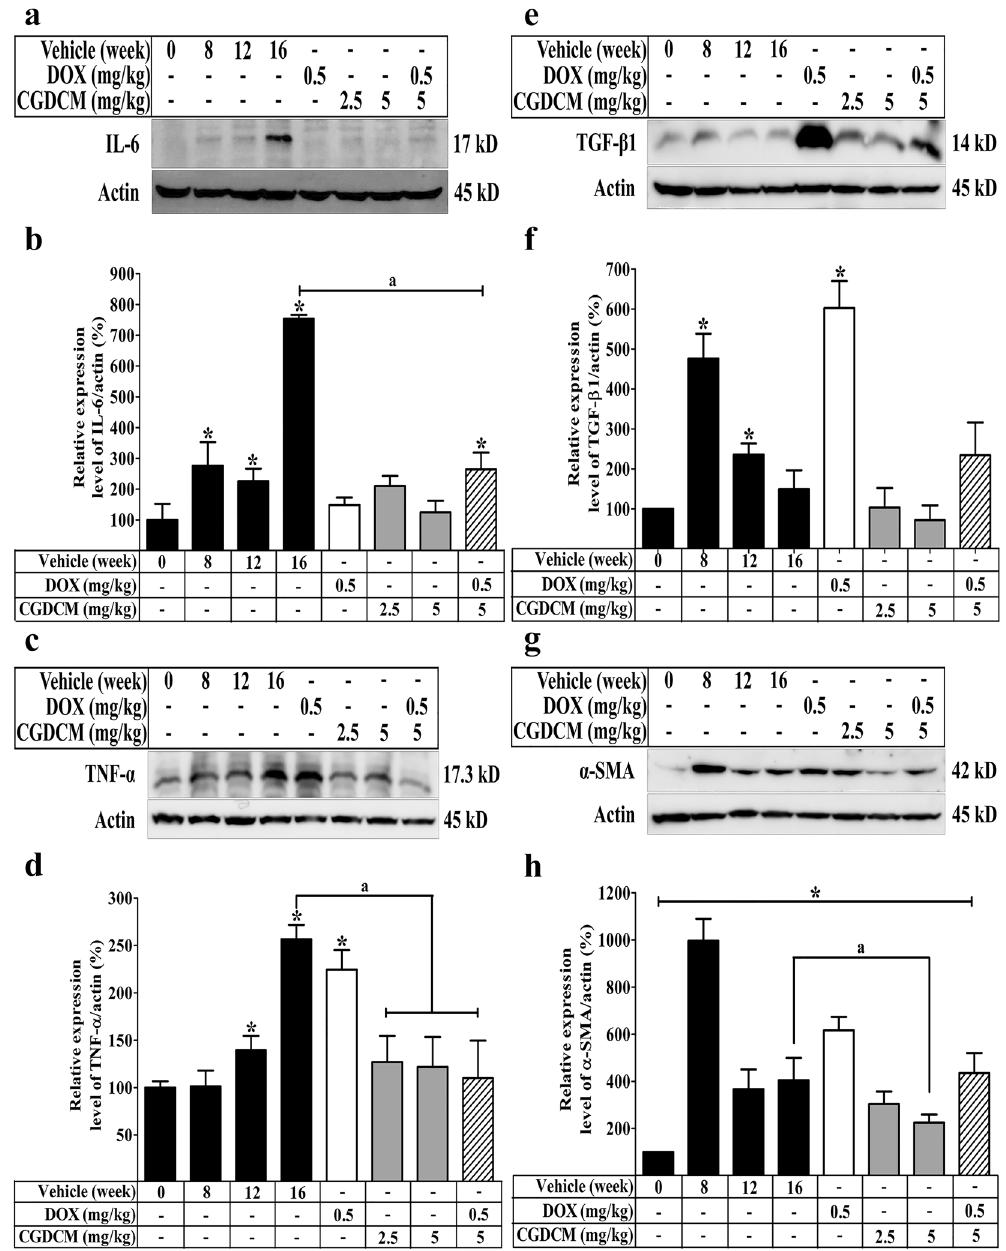
Figure 10. The effect of a combination of DOX and CGDCM extract from the stem bark of C. gigantea on the expression of inflammatory and fibrotic proteins in DEN-induced liver cancer rats. DEN administration was performed for 8 weeks, and the treatments were performed for 4 weeks from week 12, which included DOX, CGDCM-L, CGDCM-H, and the combination of DOX with CGDCM-H. The vehicle group was treated with 0.8% DMSO. Representative western blot images and quantitative analysis of the expression in a percentage of β-actin/protein expression from liver tissue of ( a , b ) IL-6, ( c , d ) TNF-α, ( e , f ) TGF-β1, and ( g , h ) α-SMA. The data are reported as the mean ± SD (n = 4) and were analyzed using one-way ANOVA with Tukey’s HSD test, *p < 0.05 compared to week 0. CGDCM , C. gigantea dichloromethane extract; CGDCM-L, CGDCM low dose; CGDCM-H, CGDCM high dose; DOX,